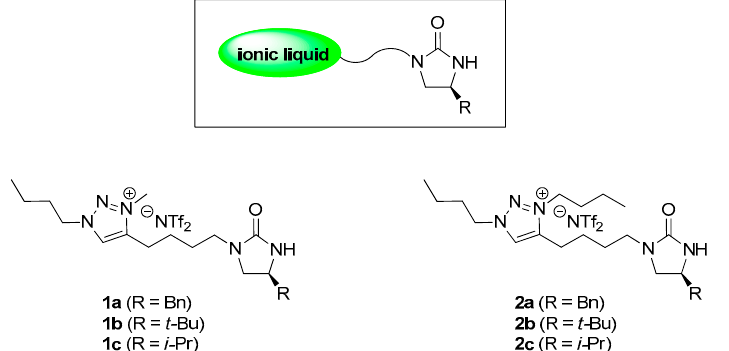
Figure 1. 1,2,3-Triazolium ionic liquid-supported chiral imidazolidinone auxiliaries 1a ‒ c and 2a ‒ c .